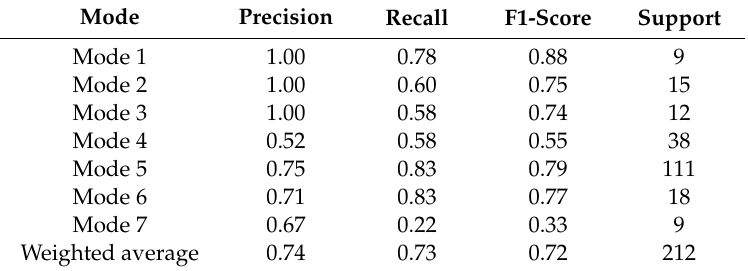
Table 3. Accuracy of the classification model for the weekday travel